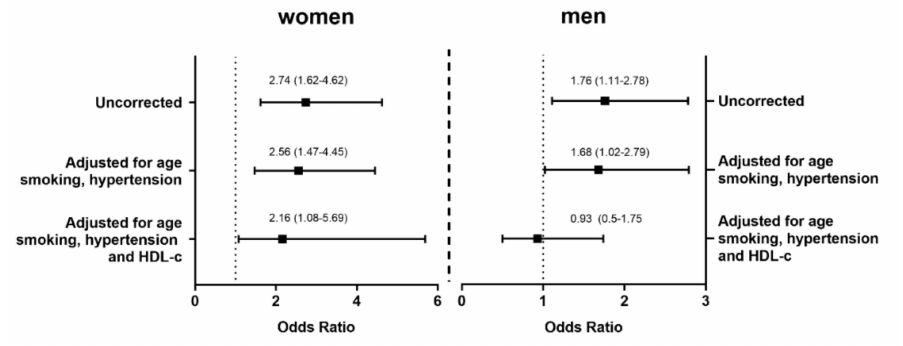
Figure 2. Odds ratios (95% C.I.) for the diagnosis of T2D in women and men with low levels (lower than IV quartile) of serum PON-arylesterase activity. Women with low levels of PON-arylesterase activity demonstrated increased odds of being a ff ected by T2D independently from all cofounding factors (left panel). On the contrary, while the uncorrected model and the model corrected for age, smoking and hypertension suggested increased odds for diabetes in men as well, the inclusion of HDL-c as covariate made the relationship non-significant. HDL-c: High Density Lipoprotein-cholesterol; T2D: Type 2 Diabetes.